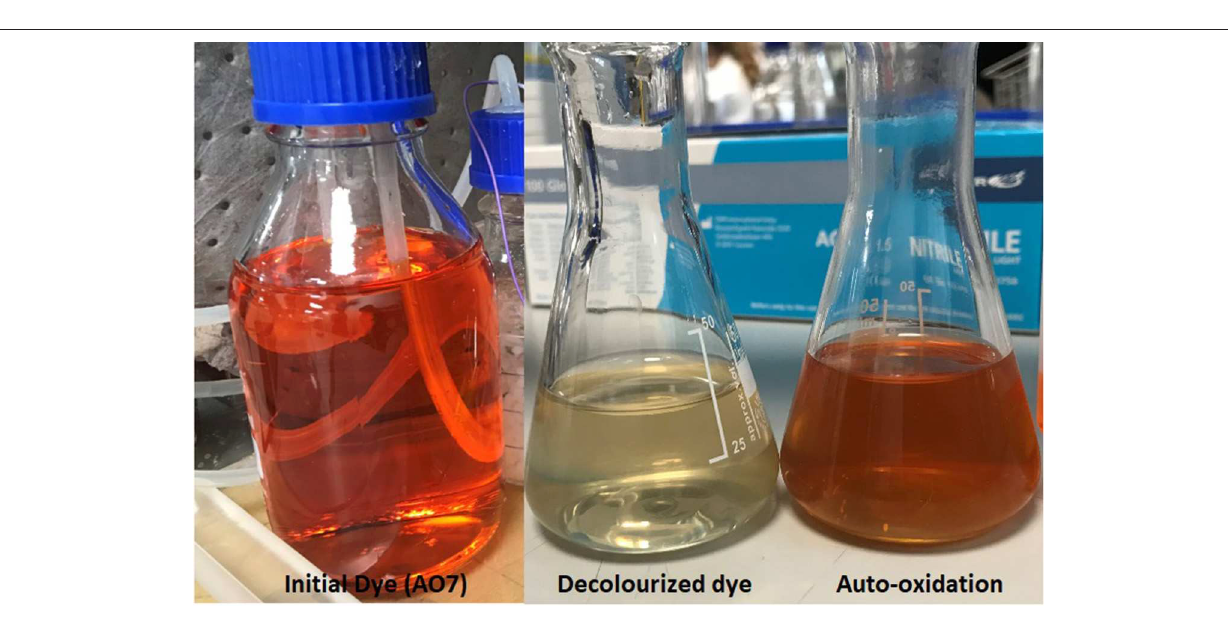
FIGURE 5 | The depiction of initial colored dye together with the decolourized products and the colored auto-oxidation